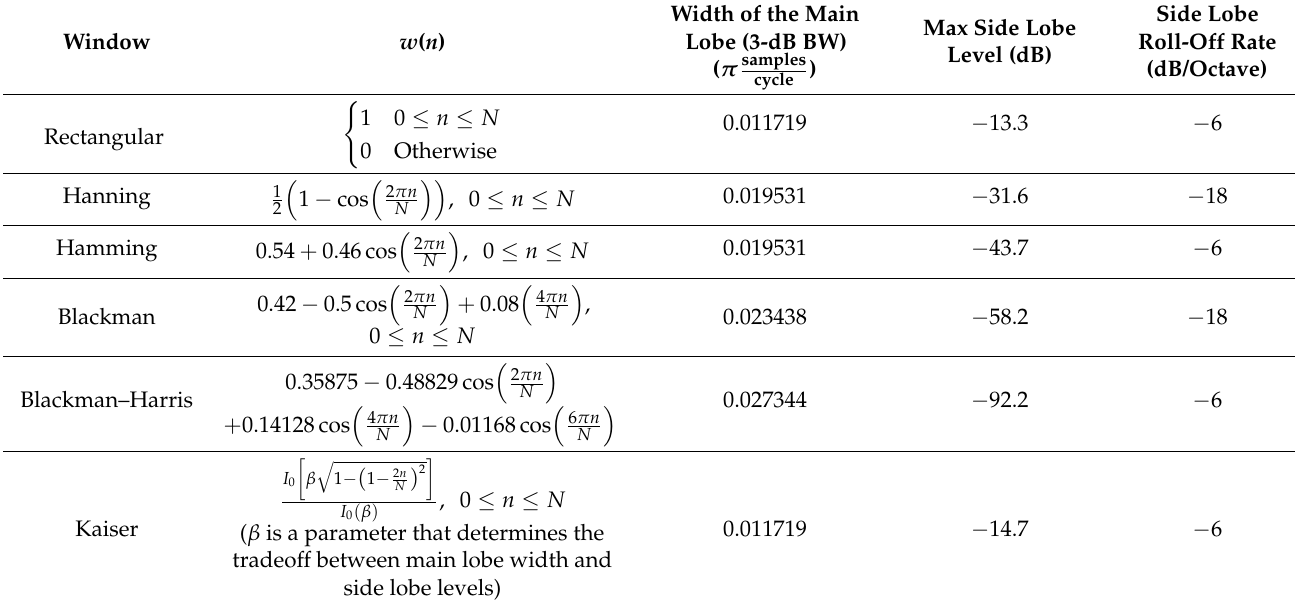
Figure 3. Spectrum of various window functions: ( a ) Rectangular window; ( b ) Hanning window; ( c ) Blackman window; ( d ) Blackman-Harris window; ( e ) Hamming window and ( f ) Kaiser window. Table 2. Properties of various window functions.